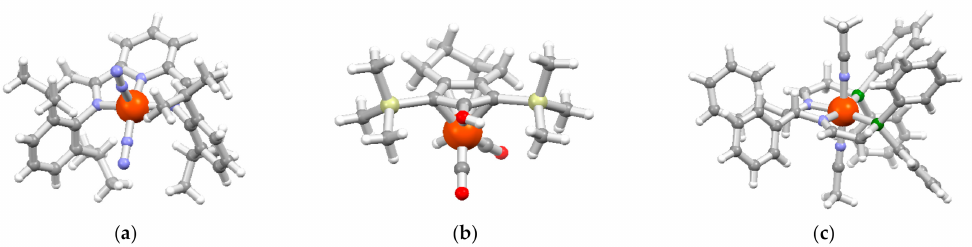
Figure 1. Crystal structures of ( a ) [Fe( i Pr PDI)(N 2 ) 2 ] (CCDC: 254793) [18], ( b ) the Knölker catalyst [Fe( η 5 -L)(CO) 2 (H)], L = 1,3-bis(trimethylsilyl)-4,5,6,7-tetrahydro-2 H -inden-2-ol (CCDC: 114304) [19], and ( c ) [Fe(L’)(CH 3 CN) 2 ](BF 4 ) 2 (L’ = ( R,R )- N , N’ - bis (2-(diphenylphosphino)ethylidene)-1,2-diphenylethylene-diamine (CCDC: 728131) [20], BF 4 anions omitted for clarity. Structures reproduced with Mercury 4.3.1 [21], color code: Fe = orange, P = green, Si = yellow, O = red, N = blue, C = grey, H =